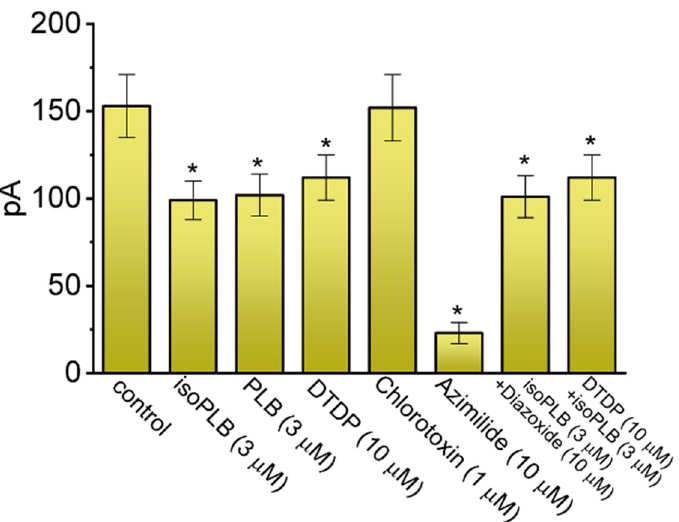
Figure 3. Comparison among effects of isoPLB, PLB, 4,4 ′ -dithiopyridine (DTDP), chlorotoxin, azi- milide, isoPLB plus diazoxide, and DTDP plus isoPLB on I K(erg) recorded from GH 3 cells . In these experiments, we placed cells in a high-K + , Ca 2+ -free solution containing 1 μ M TTX and 0.5 mM CdCl 2 , and the recording electrode was filled up with K + -containing solution. The tested cell was held at − 10 mV and a 1-sec step hyperpolarization to − 90 mV was subsequently applied to evoke I K(erg) . The current amplitude taken during cell exposure to different tested compounds was measured at the beginning of the hyperpolarizing step. Each bar represents the mean ± SEM ( n = 7–8). Statistical analyses among different groups were performed with ANOVA-1 ( p < 0.05). * Significantly different from control ( p < 0.05). isoPLB: isoplumbagin; PLB: plumbagin; and DTDP: 4,4 ′ -dithiodipyridine.